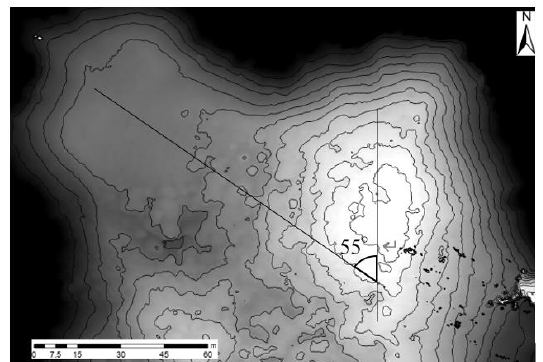
Fig.5 Crossing the main axis of the front square part and rear round part when the northernmost topography of Orono-shima Island was used as the keyhole tomb.